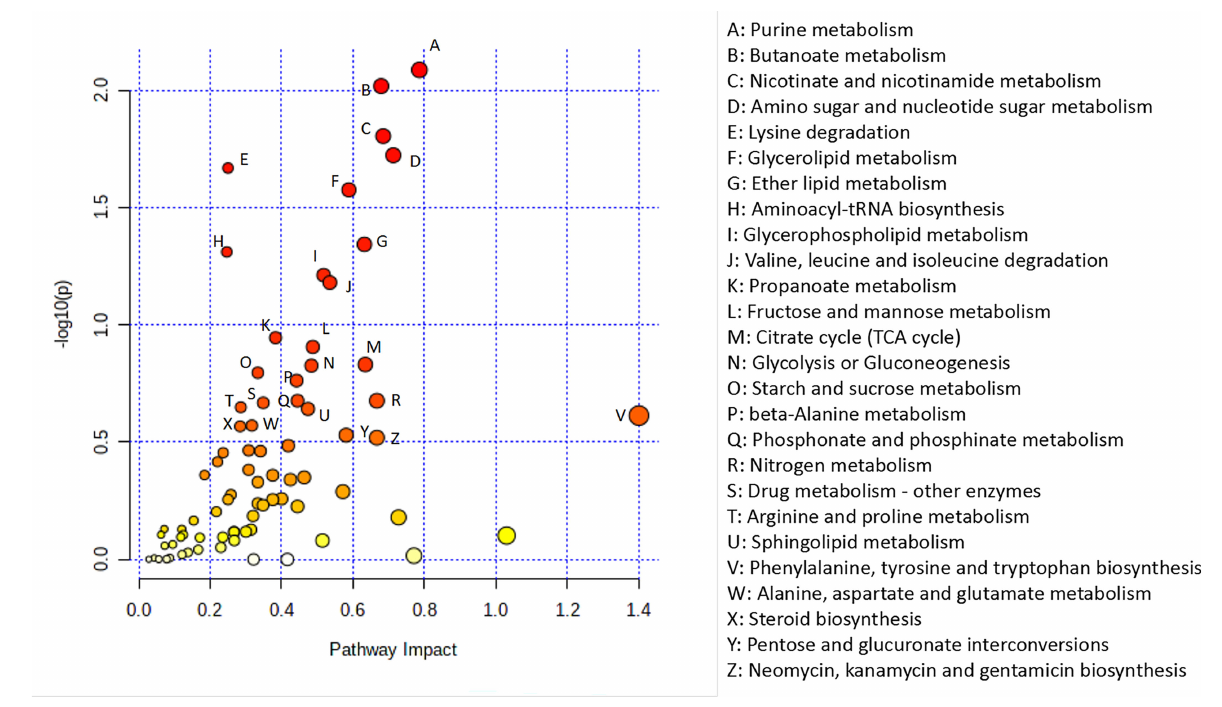
FIGURE 7 Integrated analysis of the metabolomic and transcriptomic data. Integrated analysis of the metabolomic and transcriptomic data performed with Metaboanalyst (https://www.metaboanalyst.ca/). Each point represents one metabolic pathway. The size of the dot represents a positive correlation with the metabolic